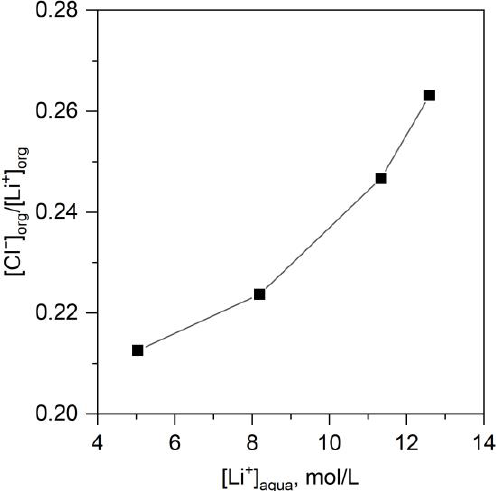
Figure 4. Ratio of equilibrium concentrations of chloride anions to lithium cations in the organic phase as a function of lithium concentration in the equilibrium aqueous phase. Extraction system LiCl-B15C5-[C8mim][NTf 2 ], C 0B15C5 = 0.5 mol/L, O/A = 1, T = 23 ± 2 °C.